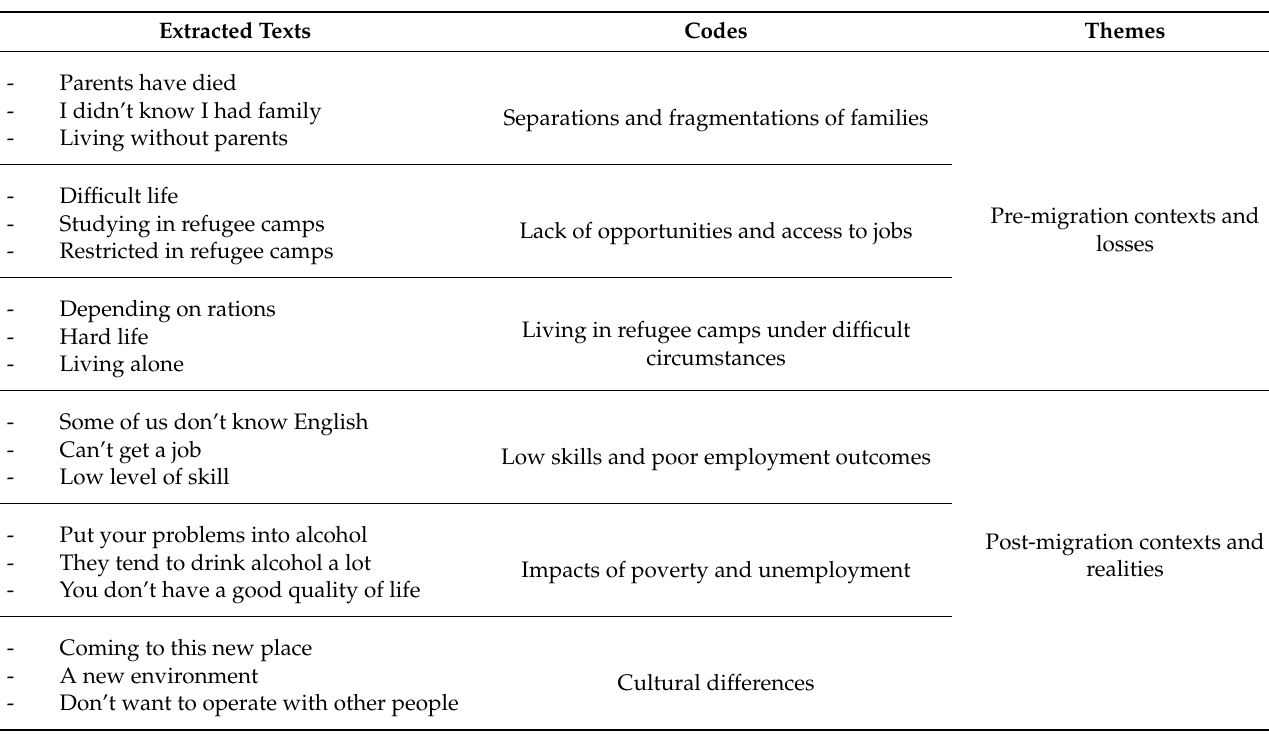
Table 2. Examples of thematic analysis and interpretation of study data.